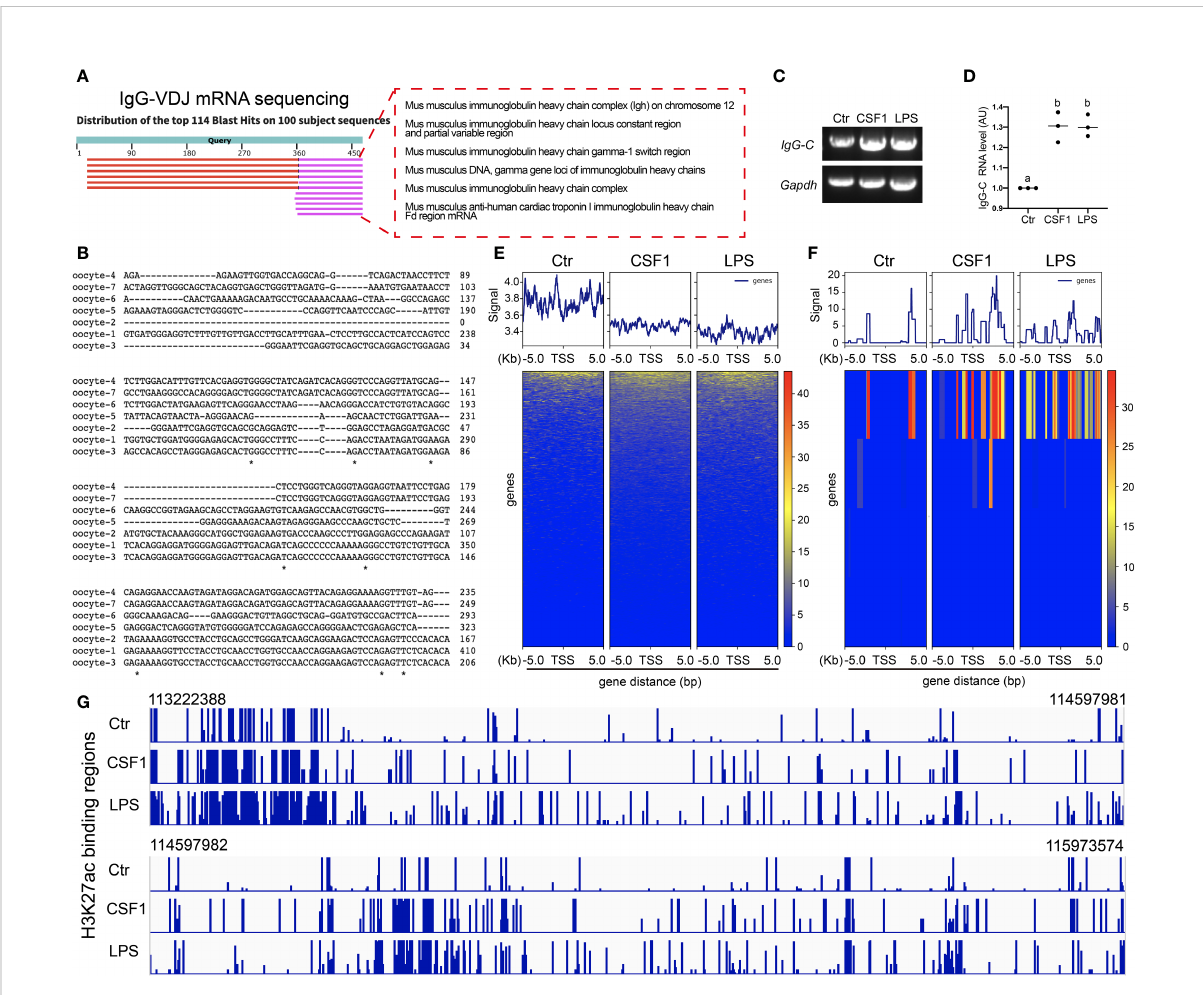
FIGURE 4 IgG transcription increased and was regulated by H3K27ac (A) Ampli fi cation of IgG-VDJ region, cloning and sequencing shows that IgG-VDJ mRNA is present in the oocyte. (B) Parallel comparison of IgG-VDJ mRNA sequences from (A) shows that IgG-VDJ mRNAs are highly distinct between different oocytes. (C, D) Ampli fi cation of IgG constant (IgG-C) region showed that IgG-C mRNA levels signi fi cantly increased on exposure to either LPS or CSF1 stimuli. (E, F) H3K27ac chip-seq showed that on exposure to either LPS or CSF1 stimuli, H3K27ac decreased its binding to the regulating sequences of all genes however, its binding to the regulating sequences of the IgG gene signi fi cantly increased. (G) Magni fi ed H3K27ac-binding regions in IgG regulating sequences showed that upon both CSF1 and LPS, H3K27ac increased its binding. Gapdh was used as a loading control. Difference lower-case letters indicate signi fi cant difference between two